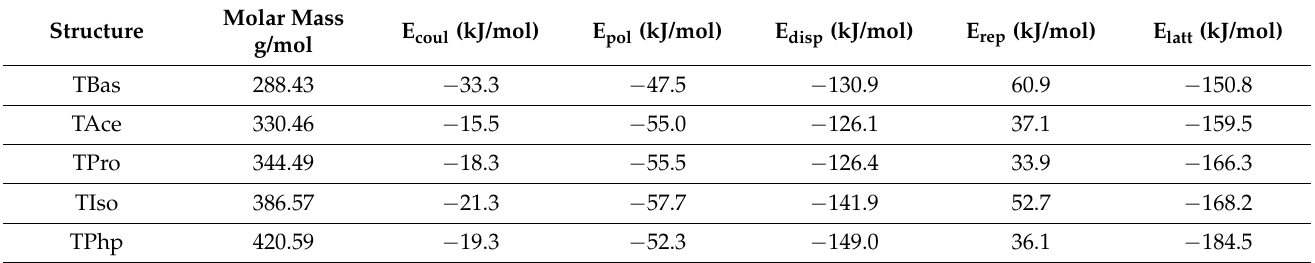
Table 2. Crystal energies of base form and its four